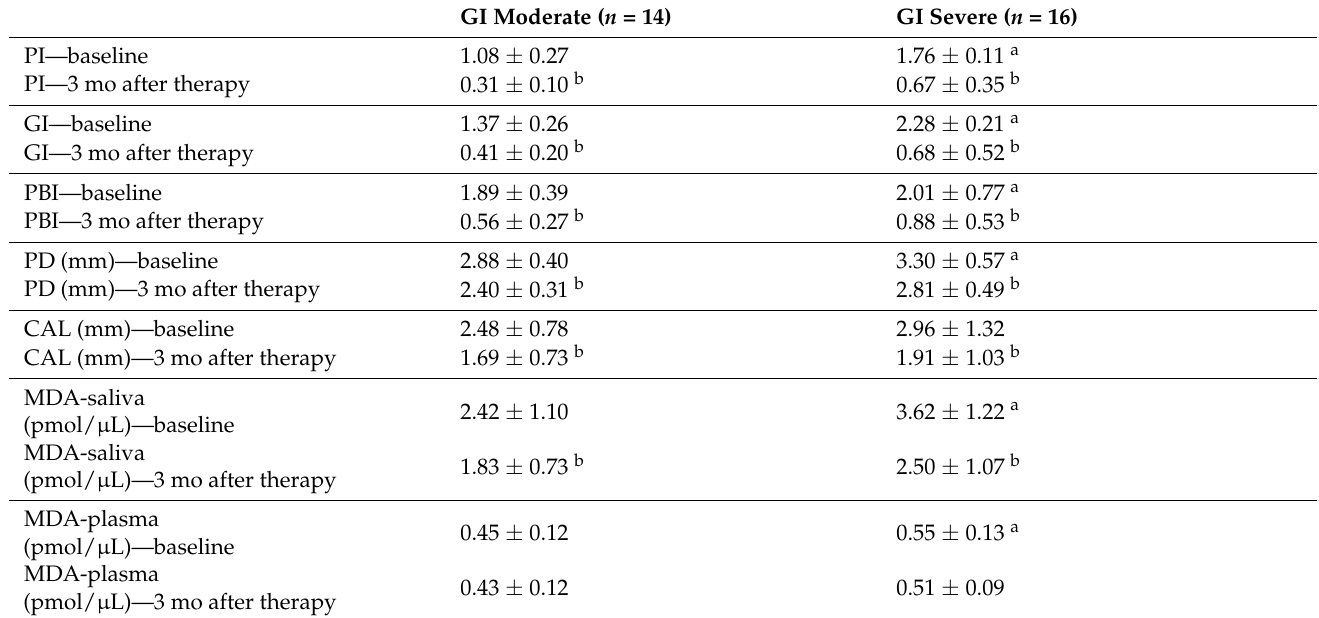
Table 3. Periodontal indices and MDA levels at baseline and three months upon therapy completion in groups with moderate and severe gingival inflammation (GI).